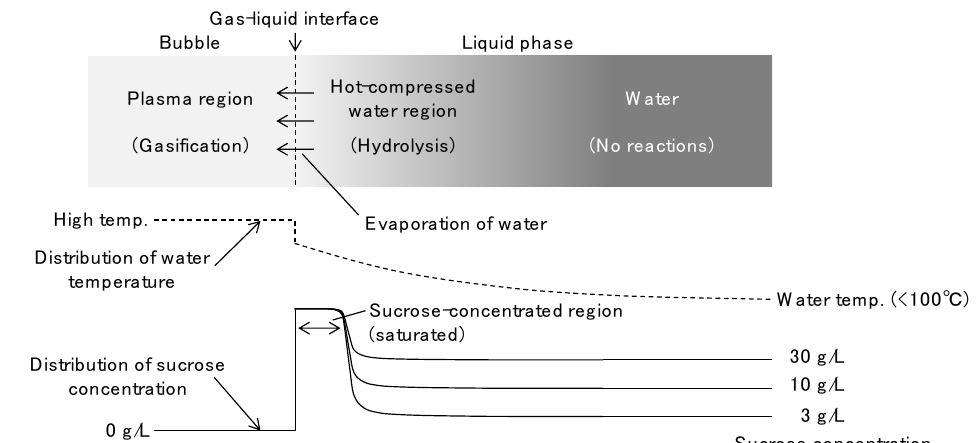
Figure 9. Possible mechanism of sucrose degradation in solution plasma.